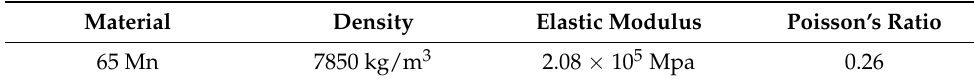
Table 2. Material parameters of the equal strength beam.